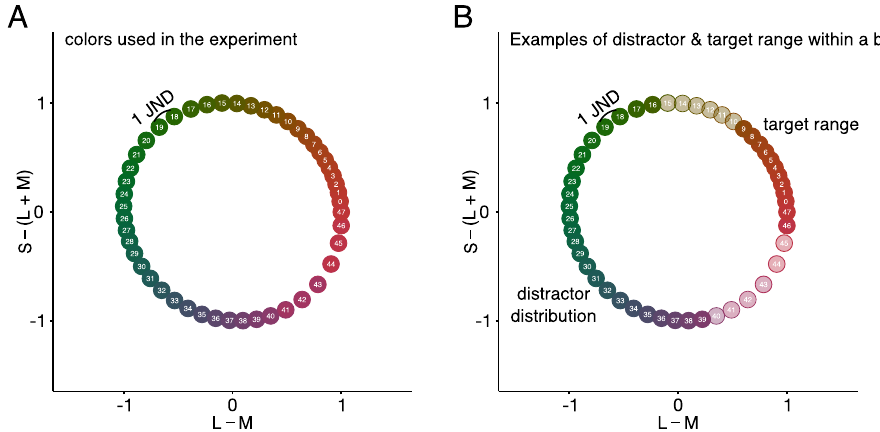
Figure 7. Color wheel with 48 hues used in our study, arranged in DKL space. Neighboring colors are approximately 1 JND apart. The x-axis corresponds to the contrast between L and M cones (L − M), roughly corresponding to the “red-green” dimension. The y-axis corresponds to the variation in S-cone excitation as L + M activation roughly corresponding to the “blue-yellow” dimension. Because of differences in sensory thresholds, colors in some parts of the circle are more distant from each other than in other parts, though differences in JNDs remain the same. ( A ) Full color wheel as used in the study. ( B ) On a particular learning block the distractor distribution and the target color range were constant. Here, the distractor distribution contains a set of greenish colors drawn from a Gaussian distribution with a range of 24 colors. Colors of the targets are obtained from a range that was minimum 18–24 JND away from the mean of the distractor distribution from each side of the distribution. This results in targets being drawn from a range of 12 reddish